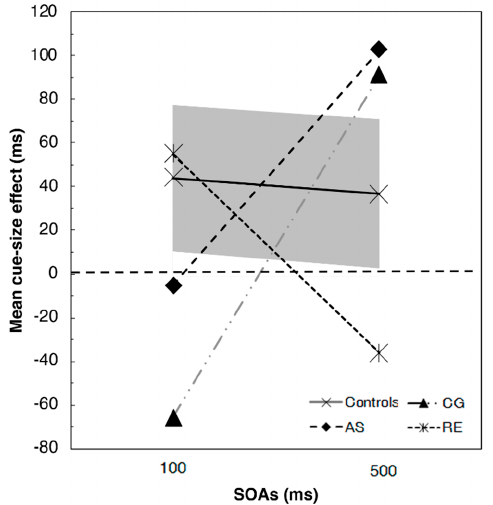
Figure 2. Results of the T detection task for the three patients and the control groups (the grey solid area represents the 95% confidence interval). Positive values indicate the presence of a cue size effect (i.e., faster reaction times for the small square compared to the big square) whereas negative values indicate the absence of such effect (i.e., faster reaction times for the big square compared to the small square).